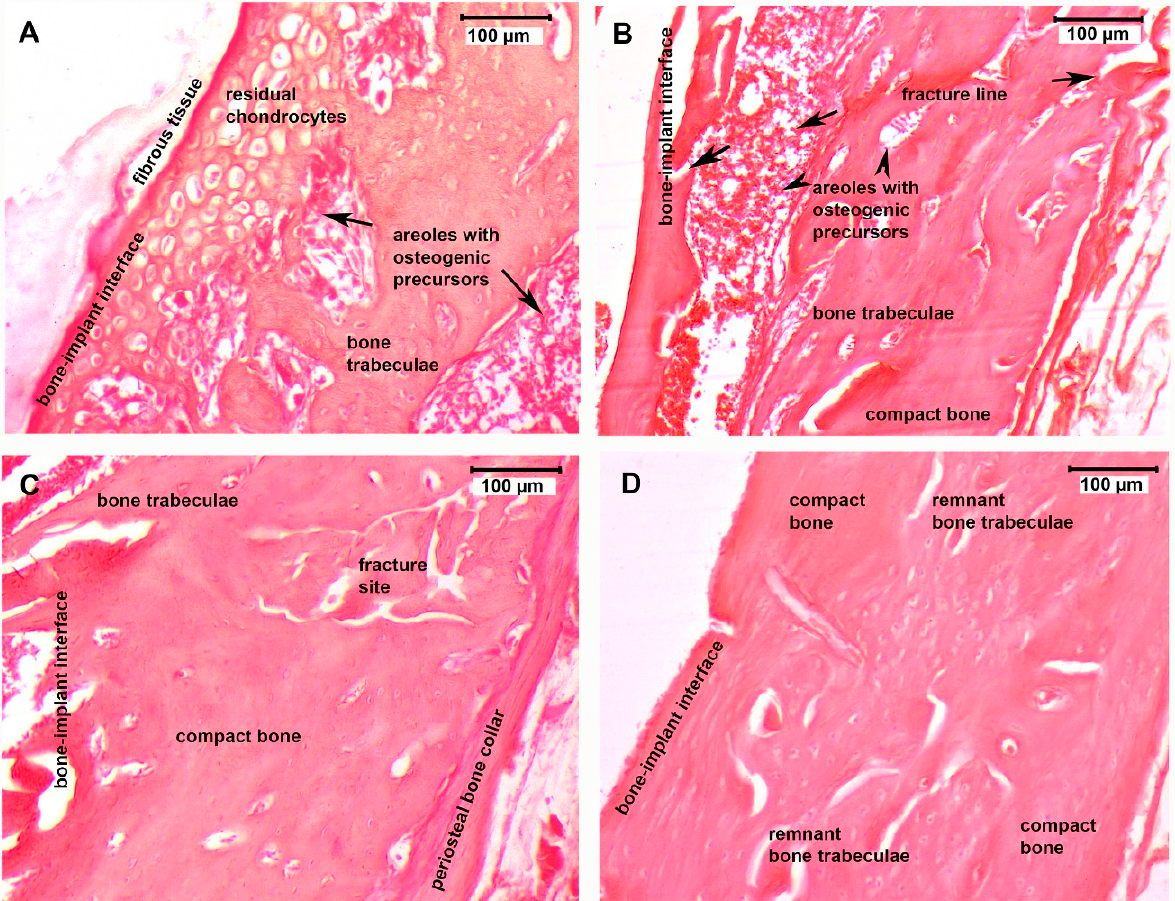
Figure 5. Optical microscopy images of H&E-stained slides of tissue samples at bone–implant interface near the fracture site at eight weeks post surgery. ( A ) In the control group, fibrotic tissue and residual cartilaginous tissues were identified in proximity with the titanium intramedullary implant, indicating a transition from cartilaginous precursors to incipient bone trabeculae formation. ( B ) The PESW group slides showed complete resorption of the fibro-cartilaginous tissue structures, which appeared irregularly disposed and less defined, but with many bone trabeculae at the fracture site. ( C ) BC group—fewer and well-defined bone trabeculae, with an osteoblast lining on their surface. Clear delimitation of the areole between the trabeculae with areas of compact lamellar bone deposition. On the lateral right side, the periosteal collar bone that formed during fracture healing can be seen. ( D ) The most advanced stage of bone remodeling with osseointegration of the titanium implant was seen in the BC-PESW group, where the trabecular bone tended to be replaced by compact bone with a lamellar disposition of bone matrix and osteocytes around Haversian canals. The bone–implant interface showed a compact bone cortex with active osteoblasts (they were round nuclei) near the medullary cavity.